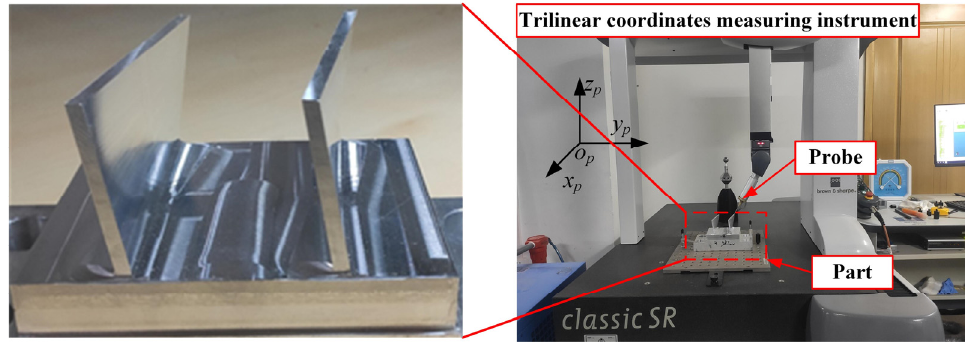
Figure 10. Measurement of surface location error of part.